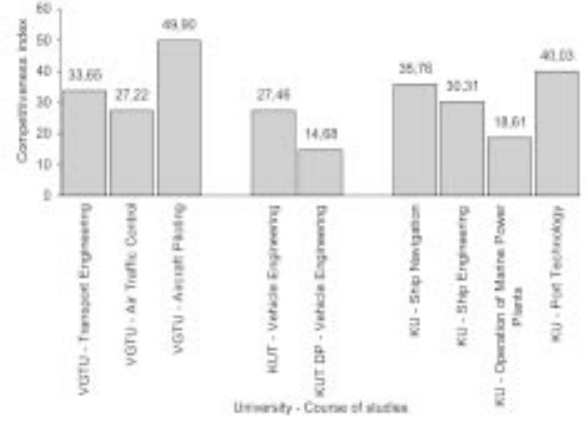
Fig 10. Competitiveness indexes of full-time studies in transport engineering courses in